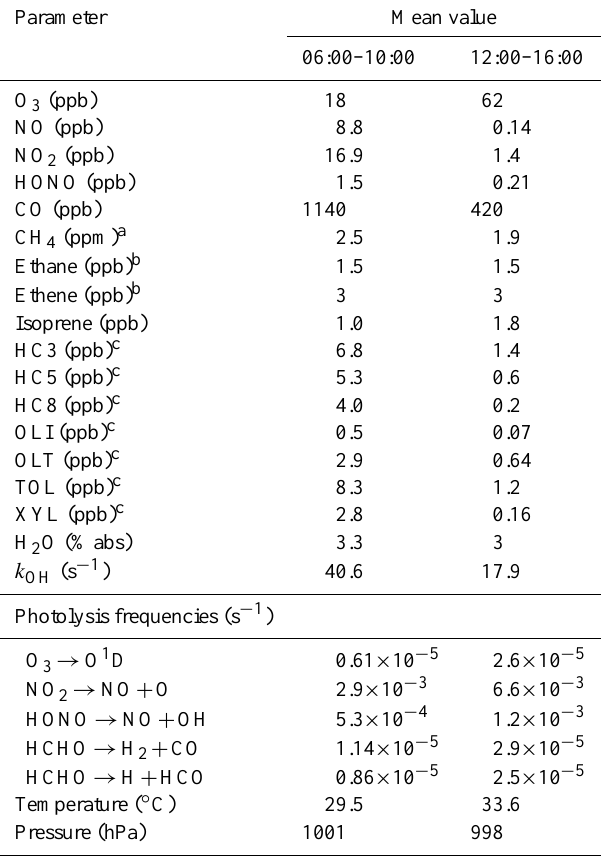
Table 3. Mean values of atmospheric parameters measured from 06:00 to 10:00CNST and 12:00 to 16:00CNST at Backgarden dur- ing 5–25 July 2006, when measured data for OH and k OH were simultaneously